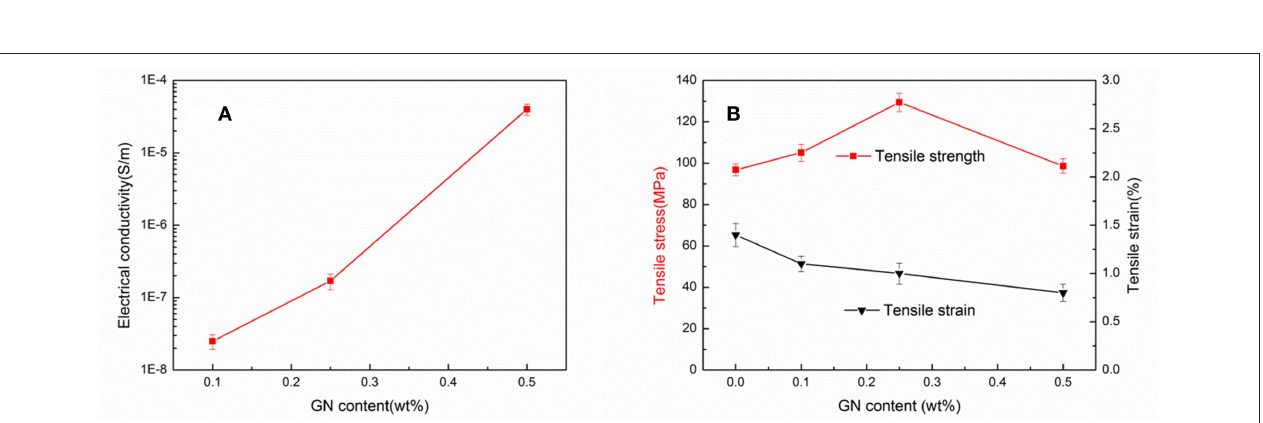
FIGURE 5 | Effect of GN content on (A) electrical conductivity and (B) tensile strength and tensile strain at break of CNW/GN composite films.